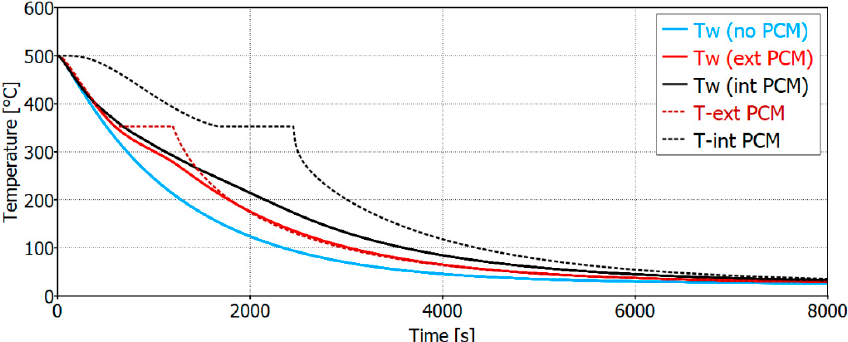
Figure 16. Effect of external and internal PCM configuration on the thermal field of a monolith during a cool-down process under zero flow conditions.